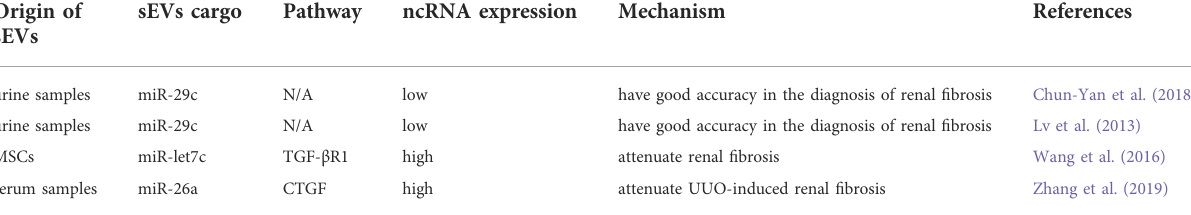
TABLE 5 The role of small extracellular vesicle non-coding RNAs in renal fi